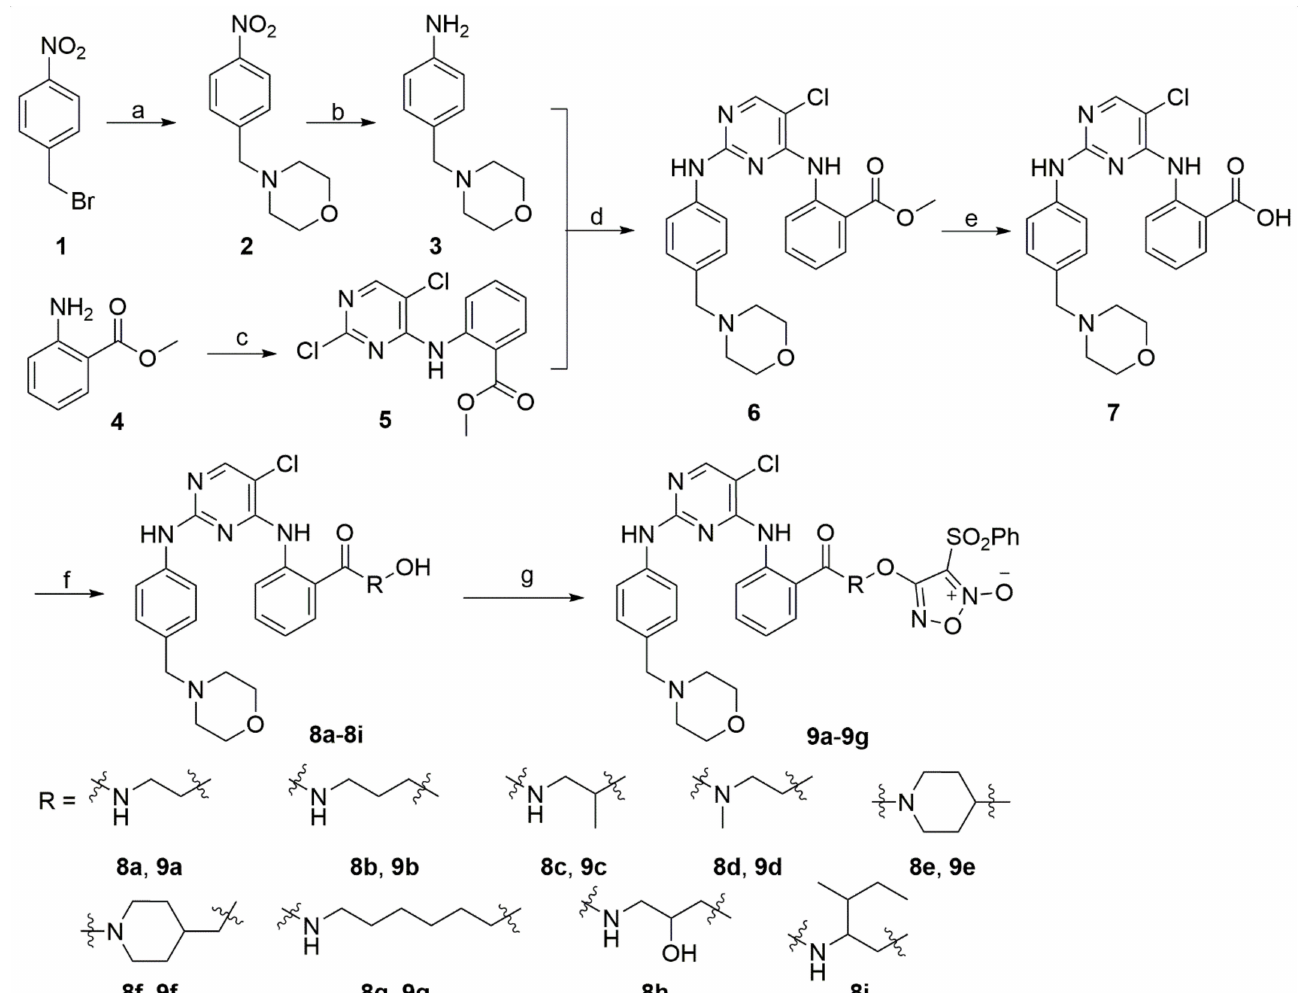
Scheme 1. Synthesis of 2,4-dianilinopyrimidines derivatives 8a – 8i and 9a – 9g . Reagents and conditions: ( a )